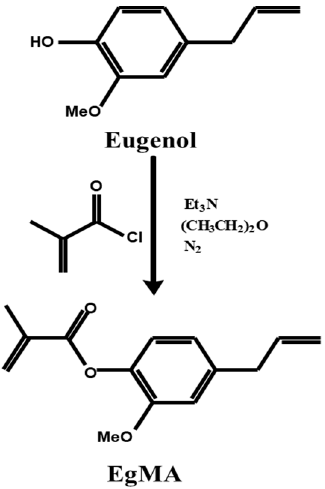
Figure 3. Synthetic scheme of the Fisher esterification of the eugenol molecule yielding its derivative eugenyl methacrylate [80].